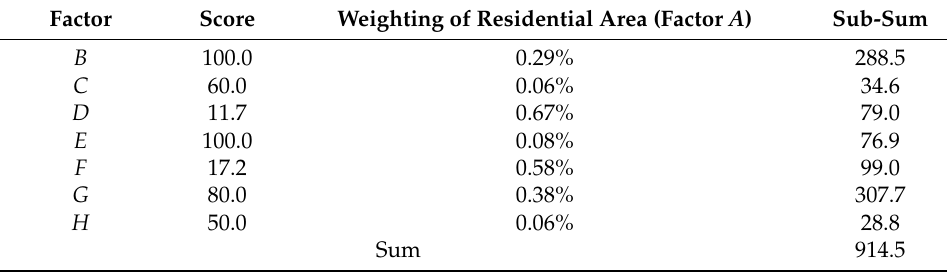
Table 4. Prediction of the number of